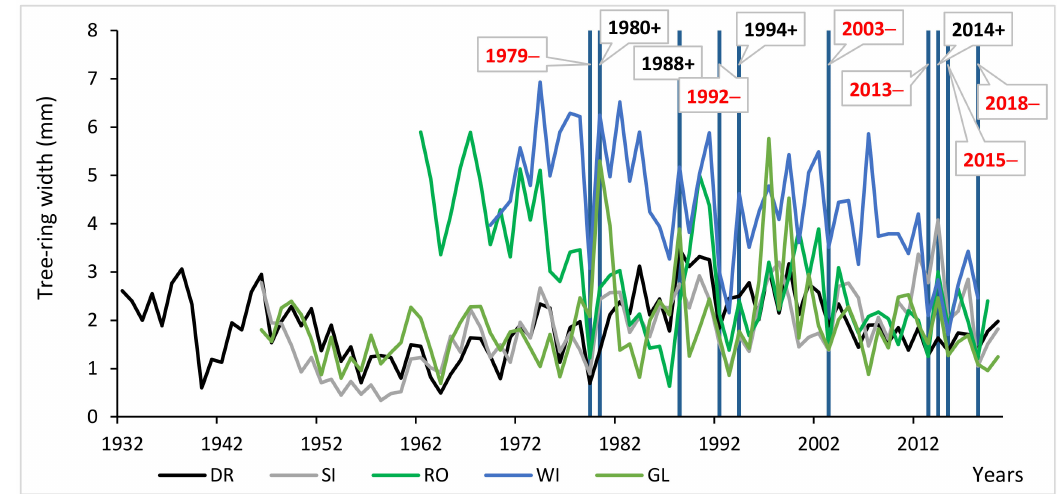
Figure 2. Local Sawara cypress chronologies (DR, SI, RO, WI and GL), and regional pointer years (blue bars; + denotes positive and – denotes negative pointer